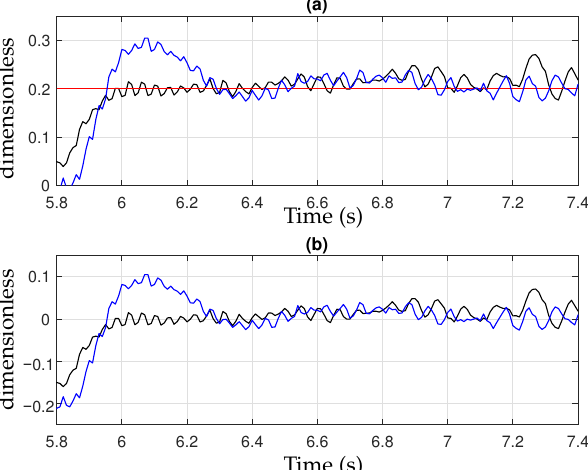
Figure 6. ( a ) Wheel slip λ : a modified HOSM controller using PID-sliding surface (14) (black), PID- like controller (26) (blue), or the reference λ ref (red) and ( b ) tracking error λ − λ ref : a modified HOSM controller using PID-sliding surface controller (14) (black) or PID-like controller (26)